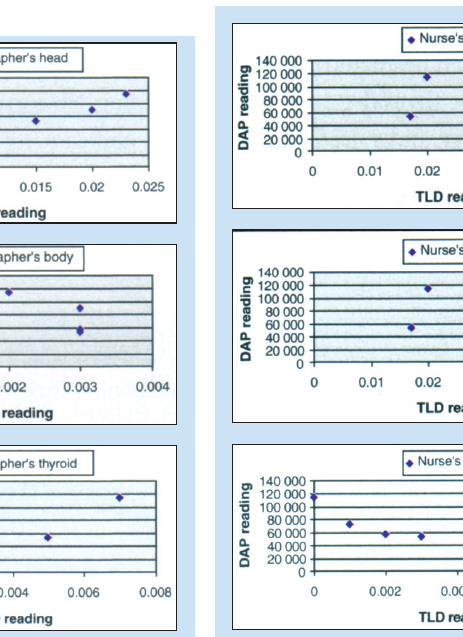
Fig. 2. Correlation between the DAP meter and radiographers’TLD meter readings.